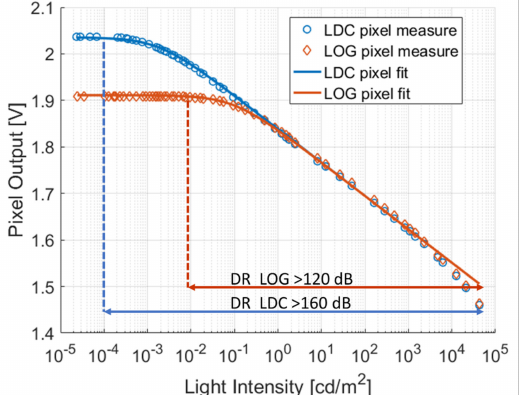
Figure 6. Measured responses of the logarithmic pixel (red diamonds) fitted with the red line compared to the proposed low dark current pixel (blue circles) fitted with the blue line. The dynamic range (DR) is highlighted for both pixel